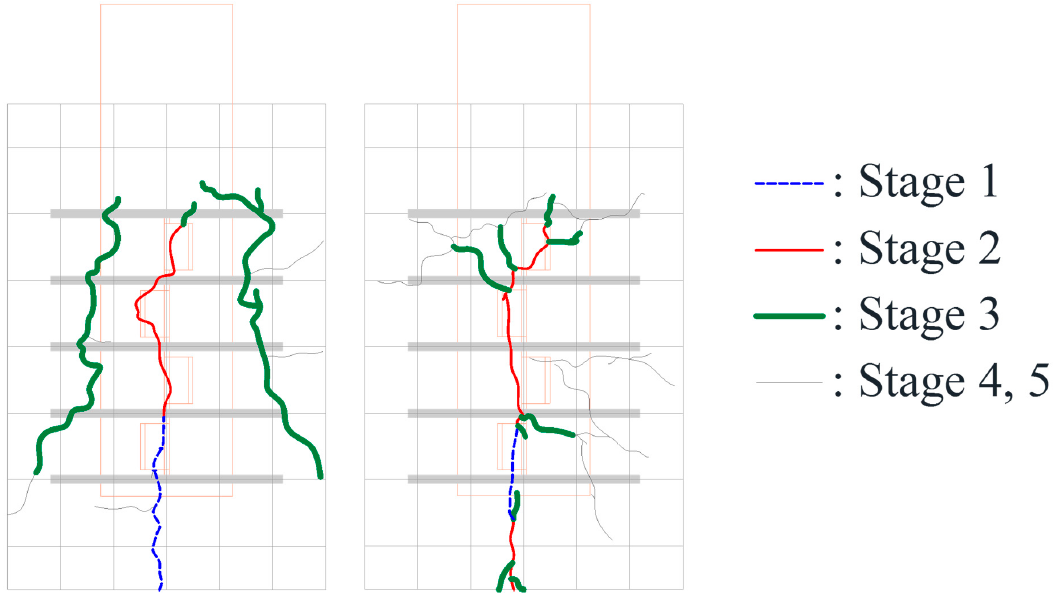
Figure 9. Crack pattern in each stage: ( a ) SY-D13-M3; ( b ) SY-D16-M3. Table 7. Crack distribution of stubby Y-type perfobond rib shear connectors.